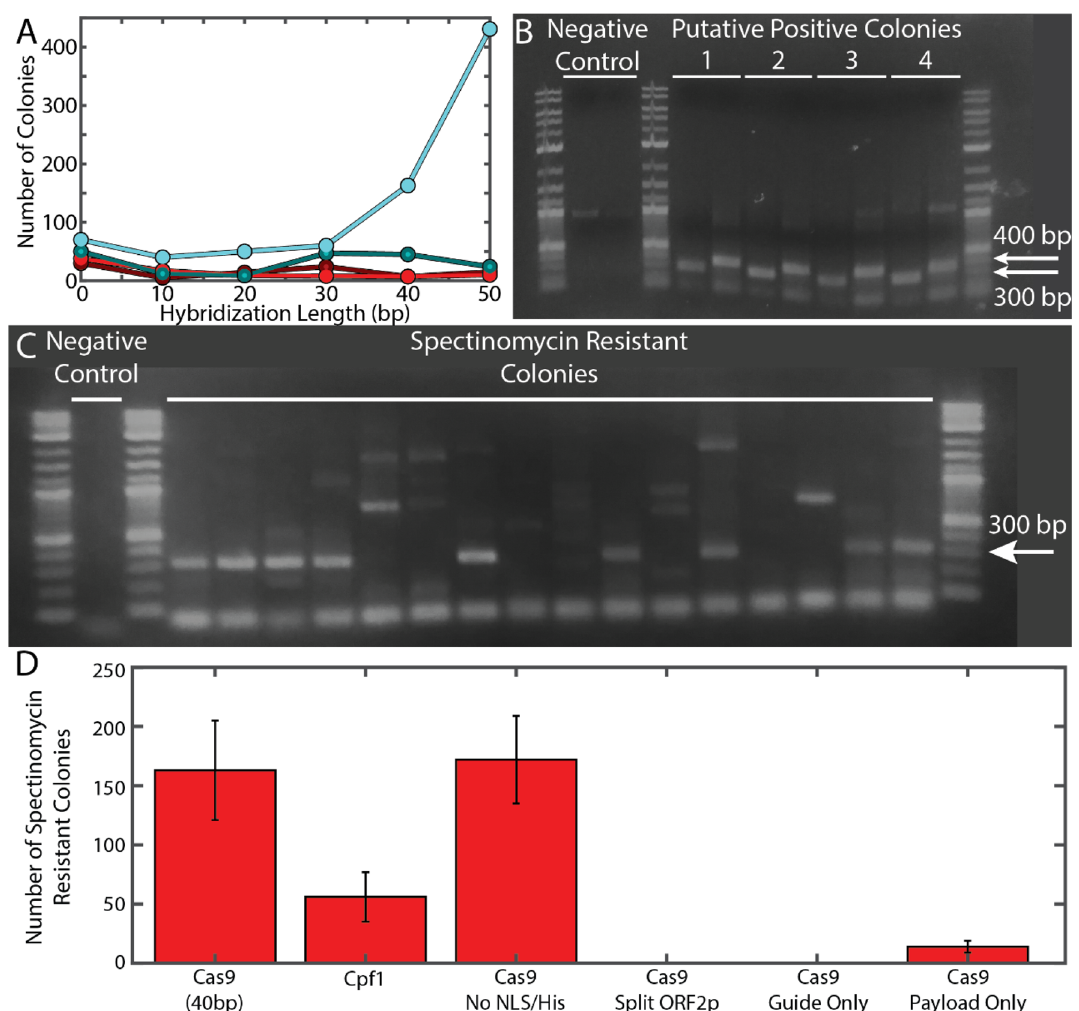
Figure 2. GENEWRITE site-specific insertion in a high-copy number plasmid. sgRNA and payload RNAs were designed to integrate an aadA spectinomycin resistance gene into the plasmid pUC57- kan . ( A ) Number of spectinomycin resistant colonies as a function of payload RNA 3’hybridization length. Dark red: -NHEJ + poly(A); Dark cyan: -NHEJ -poly(A); Bright red: + NHEJ + poly(A); Bright cyan: + NHEJ -poly(A). Data points are the average of three replicates, error bars are SD. ( B ) PCR verification of integration. Lanes 1, 4, 13: NEB 1 kb Plus Ladder. 300 and 400 bp bands are indicated. Lanes 5–12: amplicons resulting from four spectinomycin resistant colonies. For each pair of lanes, the leftmost lane is PCR across the 5’ junction (300 bp amplicon expected), rightmost is PCR across 3’ junction (400 bp amplicon expected). ( C ) Representative screening of 16 randomly selected colonies by PCR across the 5’ integration junction. ( D ) Controls and effect of various GENEWRITE components, relative to that of intact GENEWRITE-Cas9 with 40 bp homology payload RNA (first column). 2nd column: replacement of Cas9 with Cas12a/Cpf1; 3rd column: effect of removal of NLS and His tags; 4th column: simultaneous expression of unfused Cas9 and ORF2pZRT; 5th column: GENEWRITE-Cas9 transformed with only guide RNA but no payload; 6th column: GENEWRITE-Cas9 transformed with only payload RNA but no